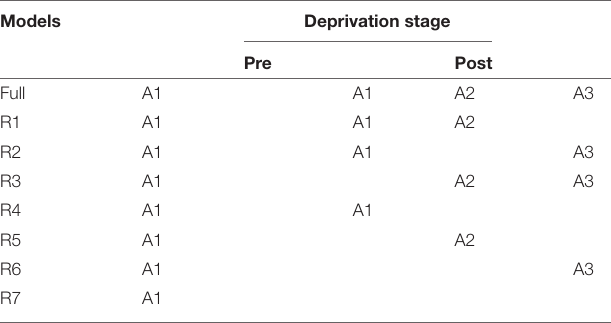
TABLE 1 | Potential